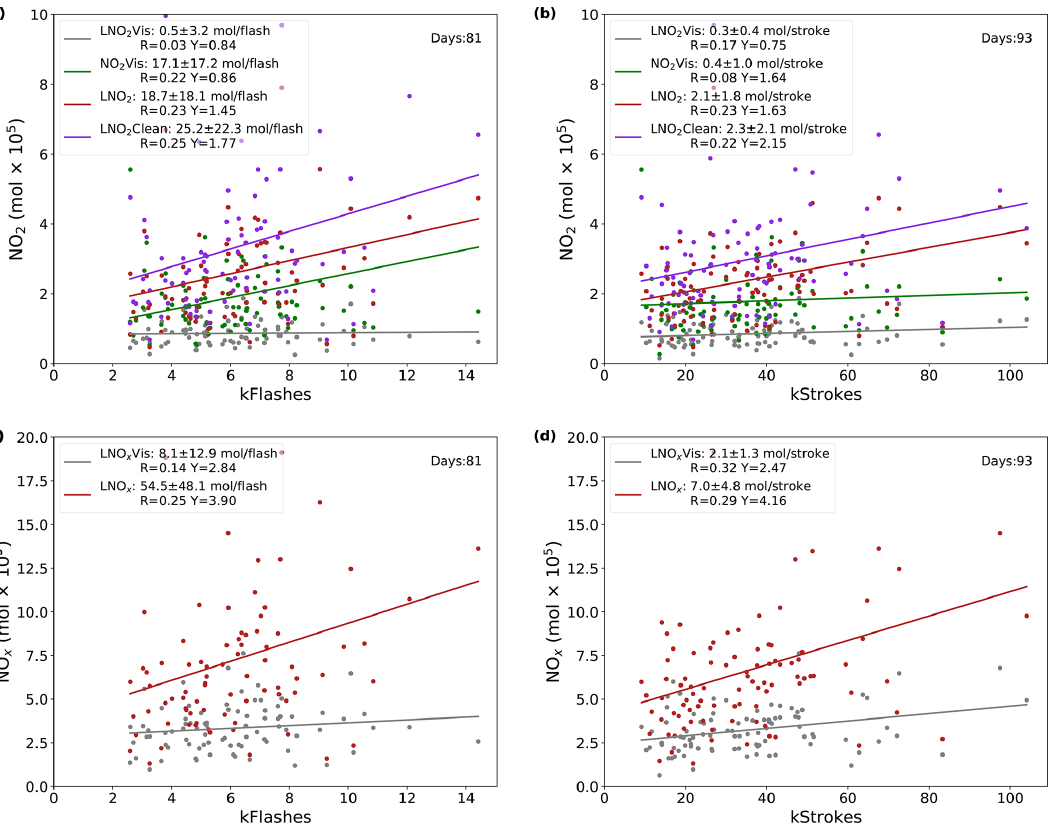
Figure 4. (a) Daily NO 2 Vis, LNO 2 Vis, LNO 2 , and LNO 2 Clean versus ENTLN total flash data. (b) Same as (a) but for strokes. (c) Daily LNO x Vis and LNO x versus total flashes. (d) Same as (c) but for